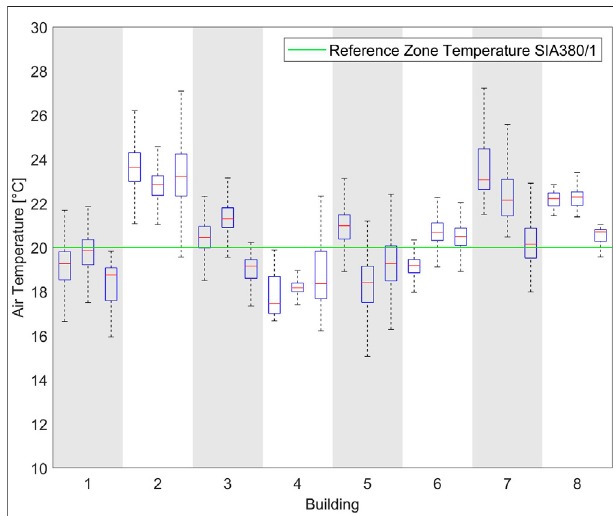
FIGURE 4 | Measured indoor air temperatures in the case study buildings. The green line indicates the standard room temperature according to